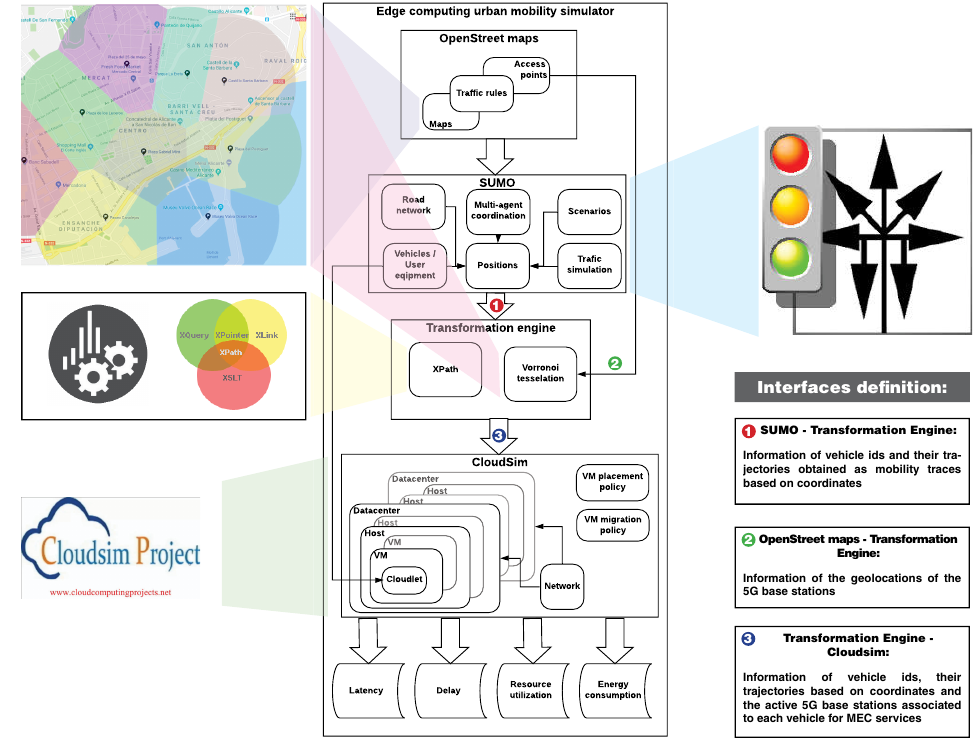
Figure 4. Integration process of the urban simulation